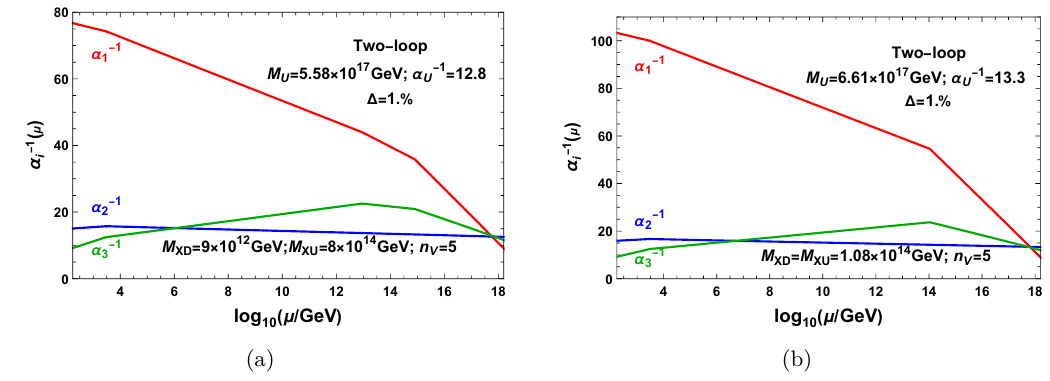
Figure 20 . Two-loop evolution of gauge couplings for the Model 24 (a) and Model 25 (b) with vector-like particles. In this model, k can be achieved by adding 5( XD + XD ) + 5( XU + XU ) .